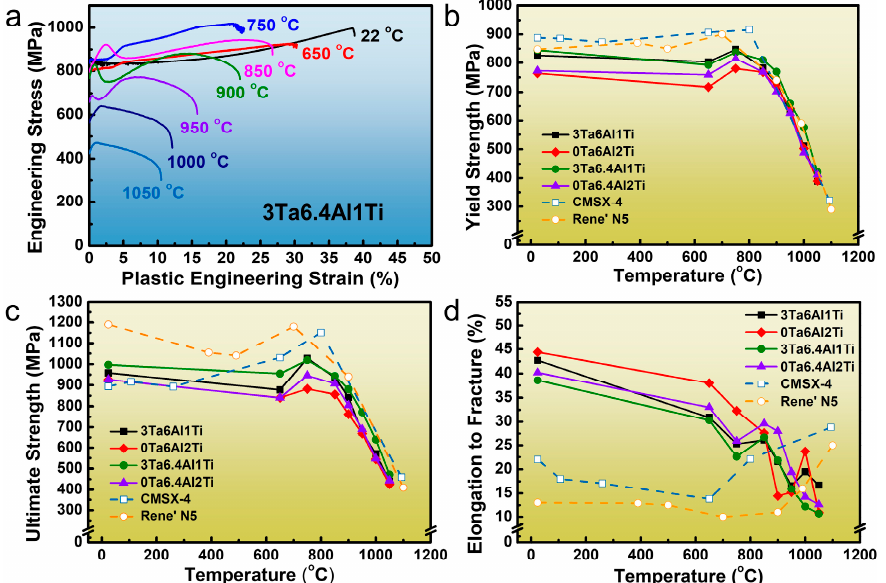
Figure 4. Tensile properties of Ni-based SX superalloys at a temperature range from RT to 1050 °C. ( a ) Stress-strain curves of Ni-based SX superalloy (3Ta6.4Al1Ti). ( b ) YS, ( c ) UTS, and ( d ) EF of four experimental alloys. For comparison, YS, UTS, and EF of two second-generation commercial alloys, CMSX-4 [32] and Rene ′ N5 [33], are also included in ( b – d ).